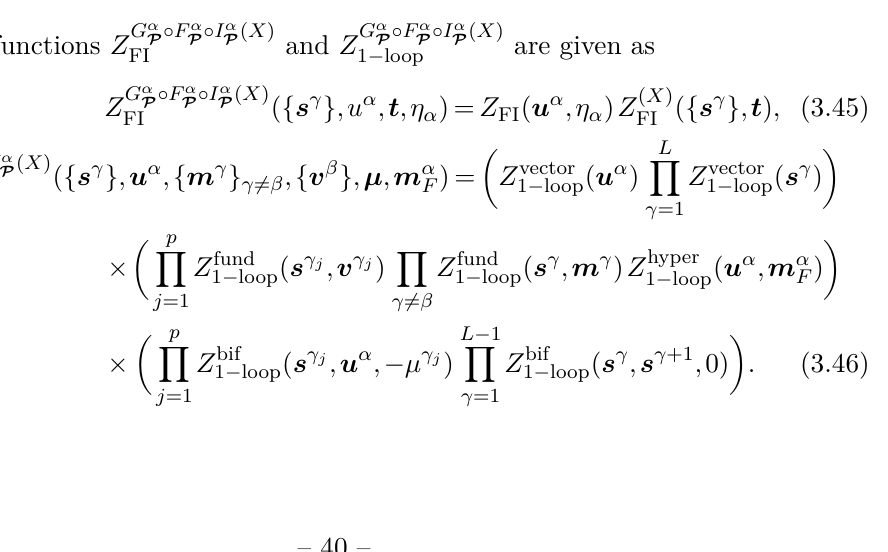
Figure 13 . This figure illustrates the identification-gauging G α quiver X involving p = 3 nodes labelled by β = α − 1 , α, α + 1